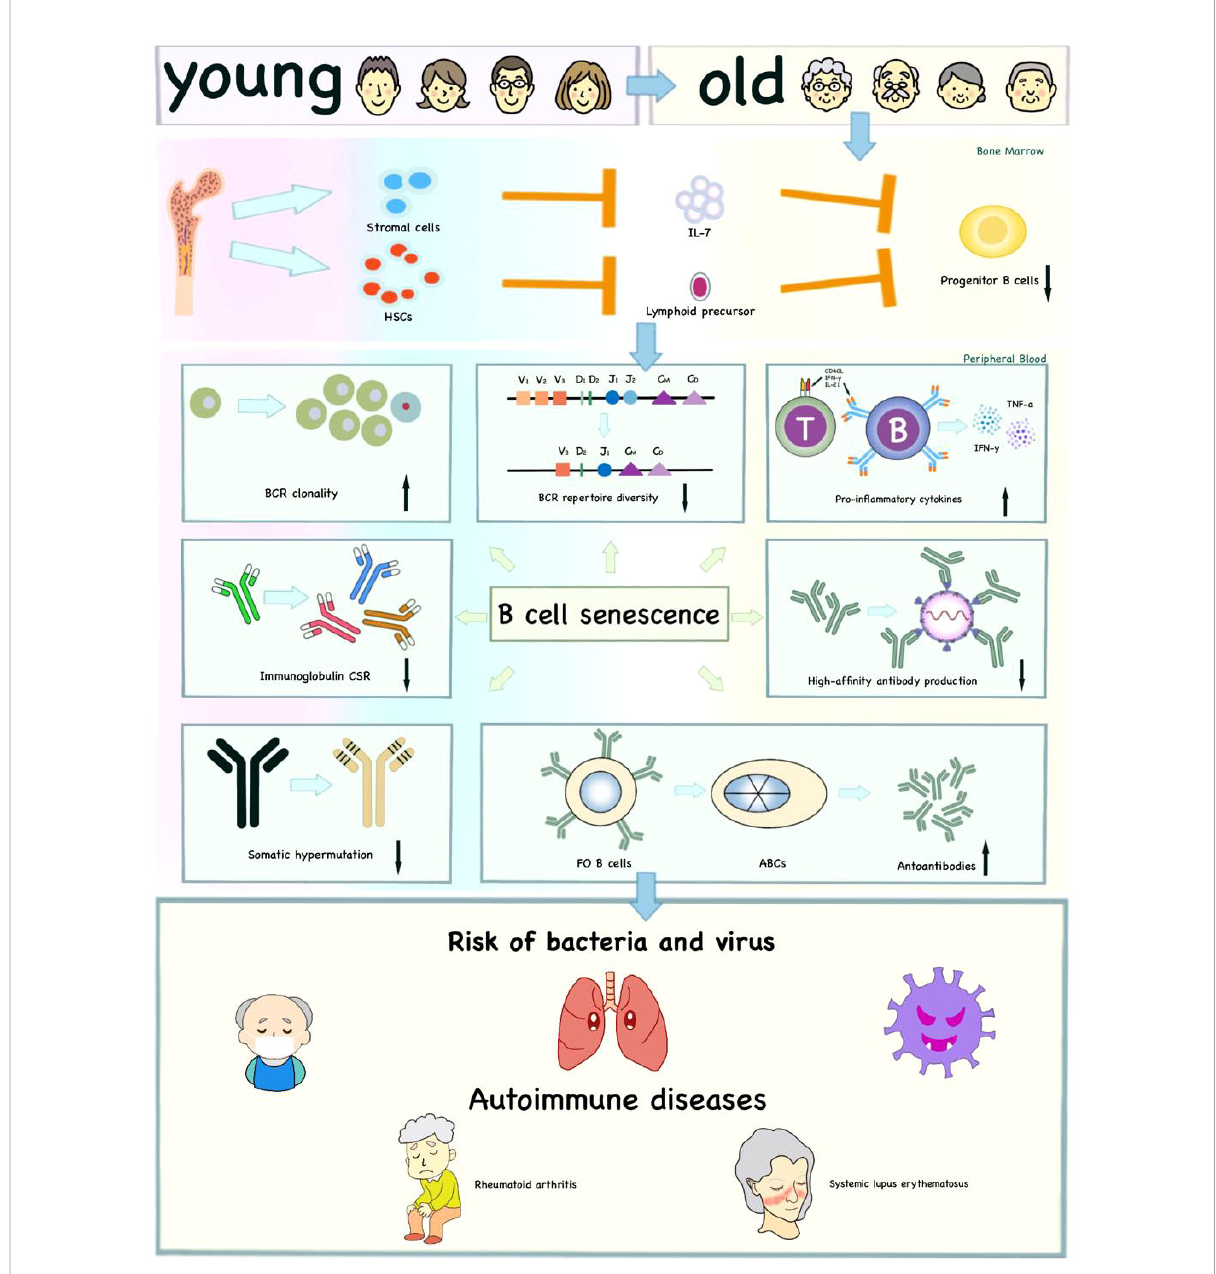
FIGURE 3 Effects of immunosenescence on B cells and age-related diseases. The reduced lymphoid output and impaired ability of bone marrow stromal cells to release IL-7 in fl uence the production of progenitor B cells with age to some extent. Moreover, immunosenescence affects the intrinsic defects of B cells, including decreased BCR repertoire diversity, CSR, SHM, high-af fi nity antibody production and increased BCR clonality. The ABCs increase autoantibodies and pro-in fl ammatory cytokines. These age-related changes together increase the risk of infection and autoimmune diseases in the